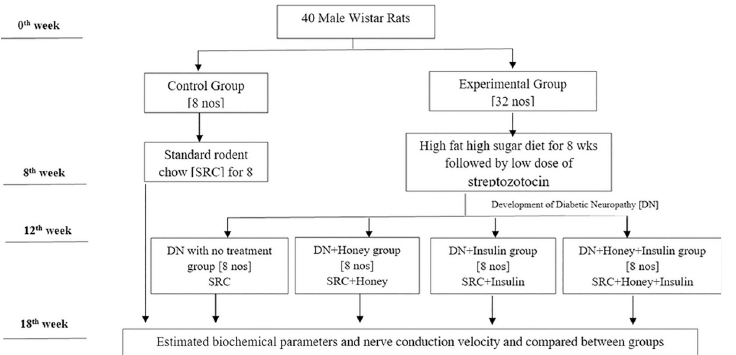
Fig 1. Schematic representation of the experimental